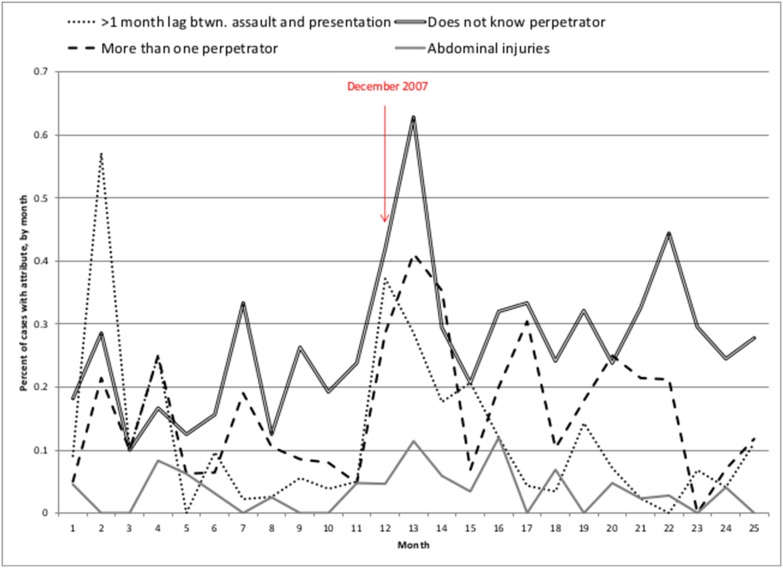
Percent of cases with significant characteristic, by month (January 2007–January 2009)*.
*Series has been abbreviated to display multiple characteristics during PEV period.